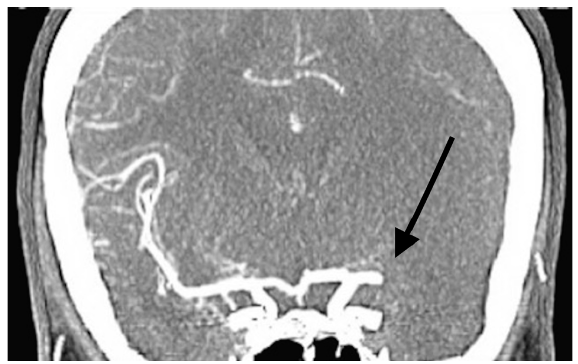
Fig. 2. Computed tomography scan with contrast coronal image demonstrating loss of cerebral blood flow to the left middle cerebral artery (black